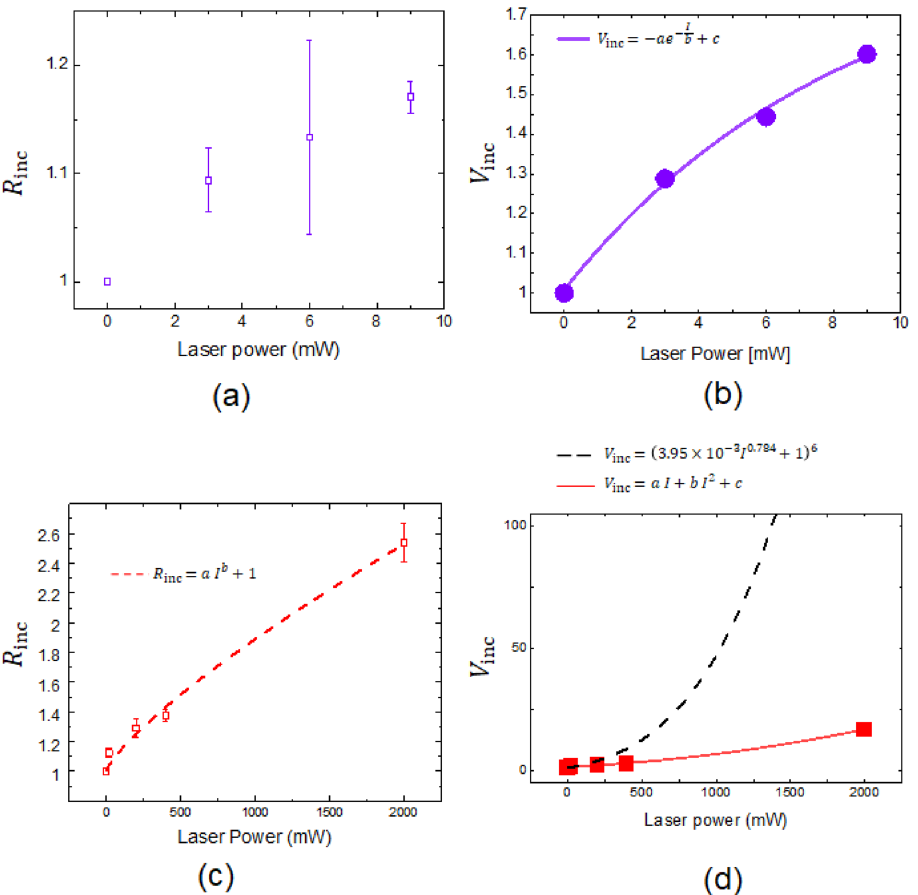
Figure 3. Power and wavelength dependence of Ag deposition on Au NPs. ( a ) Relative radius increase ( R inc ) for 325 nm irradiation. ( b ) Volume increase ratio ( V inc = R V = a exp ( − I / b ) + c , where I is the incident laser power. ( c ) R inc R = aI b + 1 . ( d ) V inc inc for 808 nm irradiation with fitted solid red curve of field effect and fitted black dashed curve of V inc =